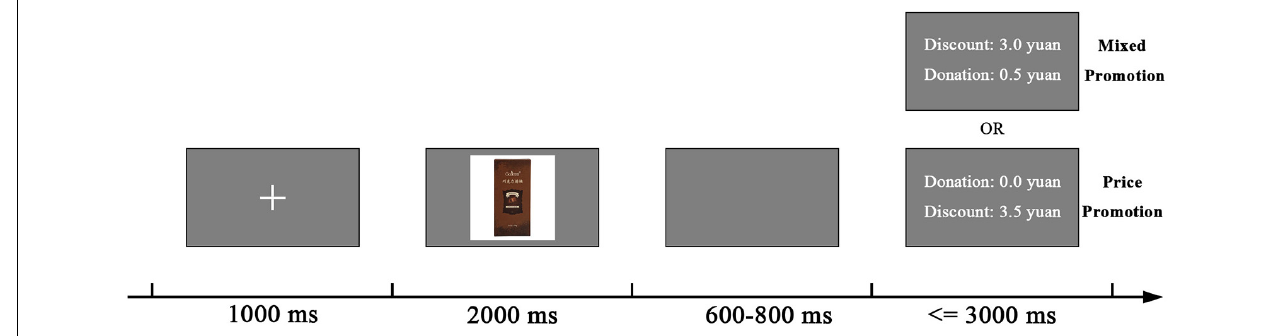
FIGURE 1 | Sequence of stimuli in each trial. Epochs are extracted after promotion information onset.